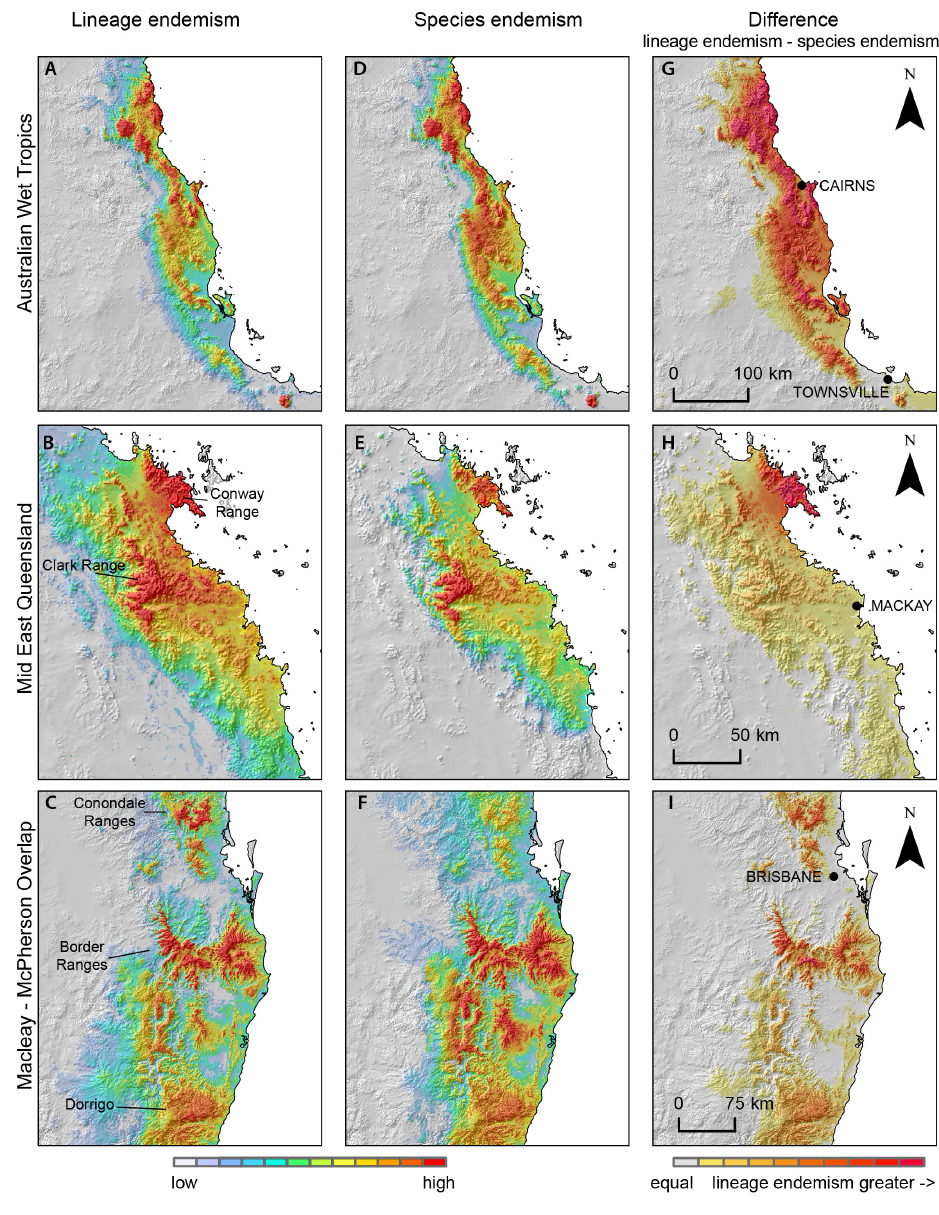
Fig 5. Lineage endemism (left column), species endemism (middle column), and the difference between them (right column), for three areas. Places labelled on panels A-C refer to areas of high endemism. Colours by quantile classes, separately for each